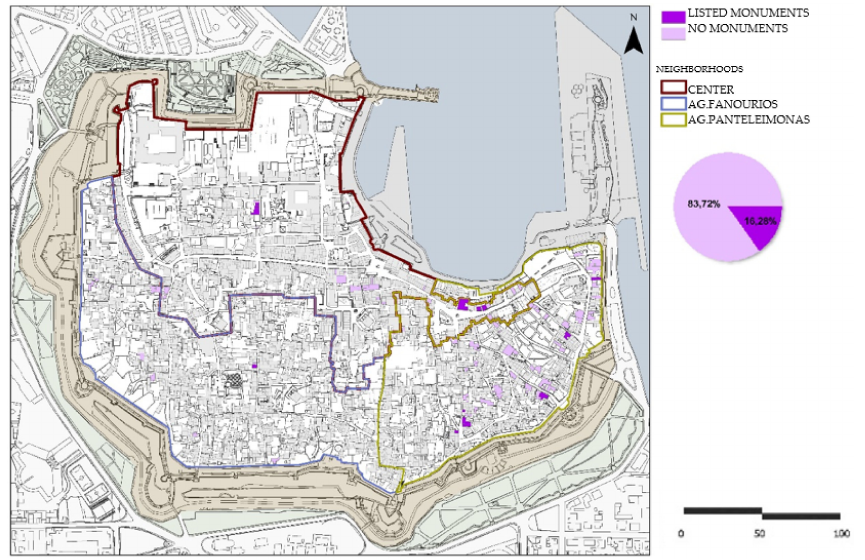
Figure 19. Listed monuments of the selected buildings.